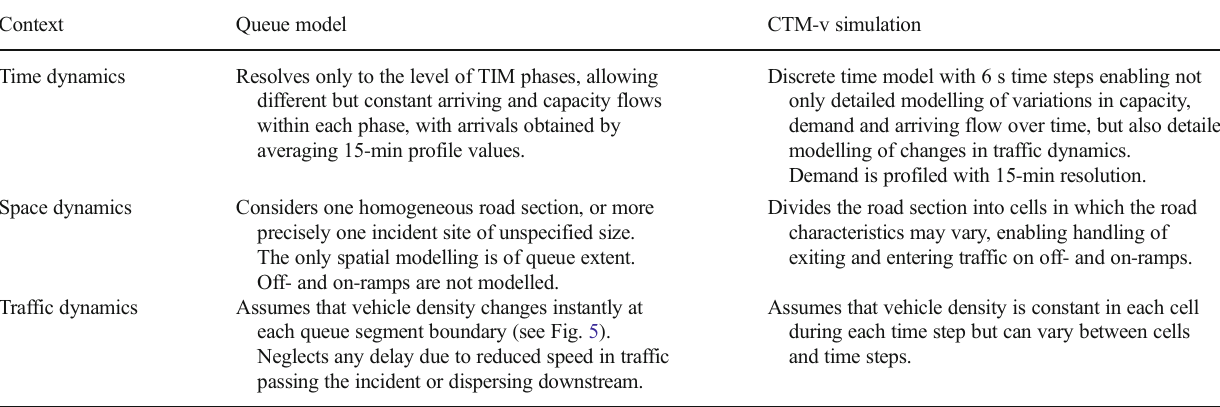
Main assumptions in and differences between the modelling